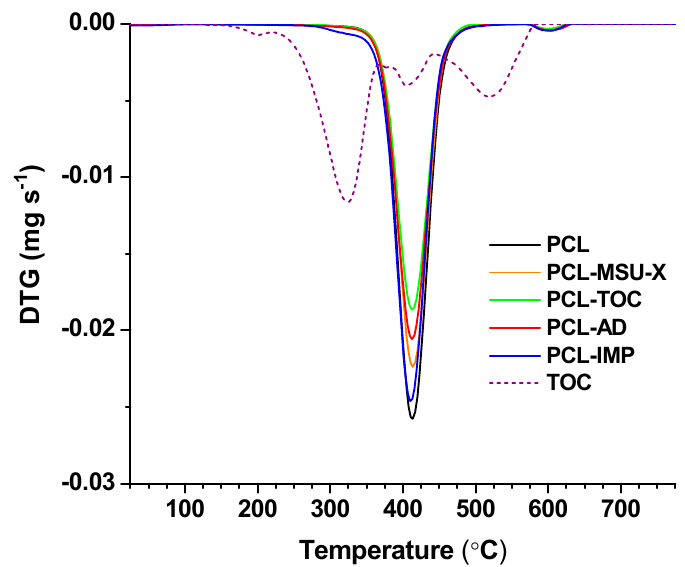
Figure 2. Derivative thermogravimetry (DTG) curves in nitrogen atmosphere at 10 °C min − 1 of PCL-based films, TOC and MSU-X.